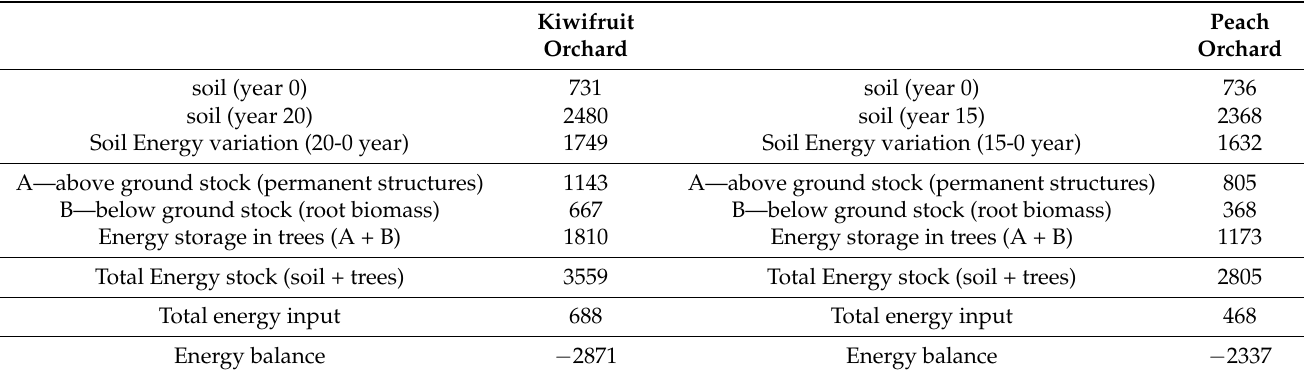
Table 7. Energy incorporated in the soil and in permanent structures in the whole production cycle (20 and 15 years for kiwifruit and peach orchards, respectively) and energy balance of the examined orchard systems. Values are expressed as GJ ha − 1 . Negative values indicate an energy gain by the